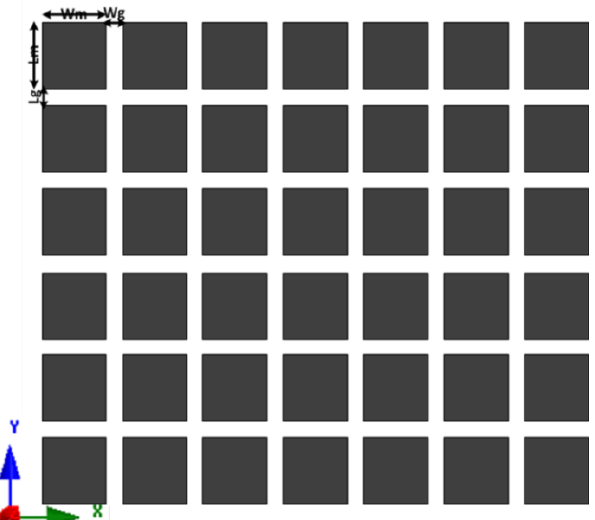
Figure 4. Schematic of the proposed 7 × 6 element